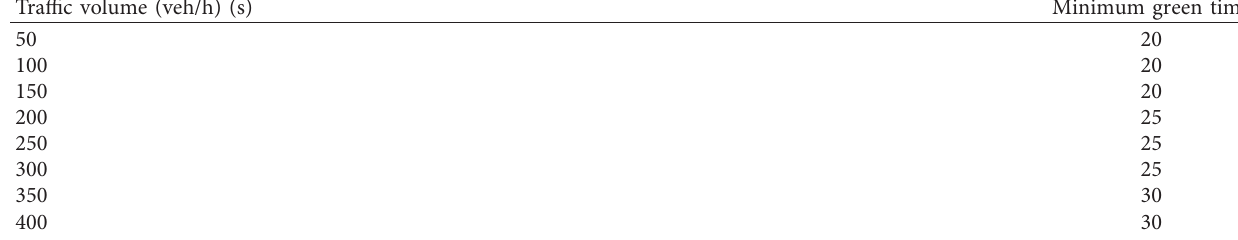
Table 3: Minimum green time for different traffic volumes of the secondary road.